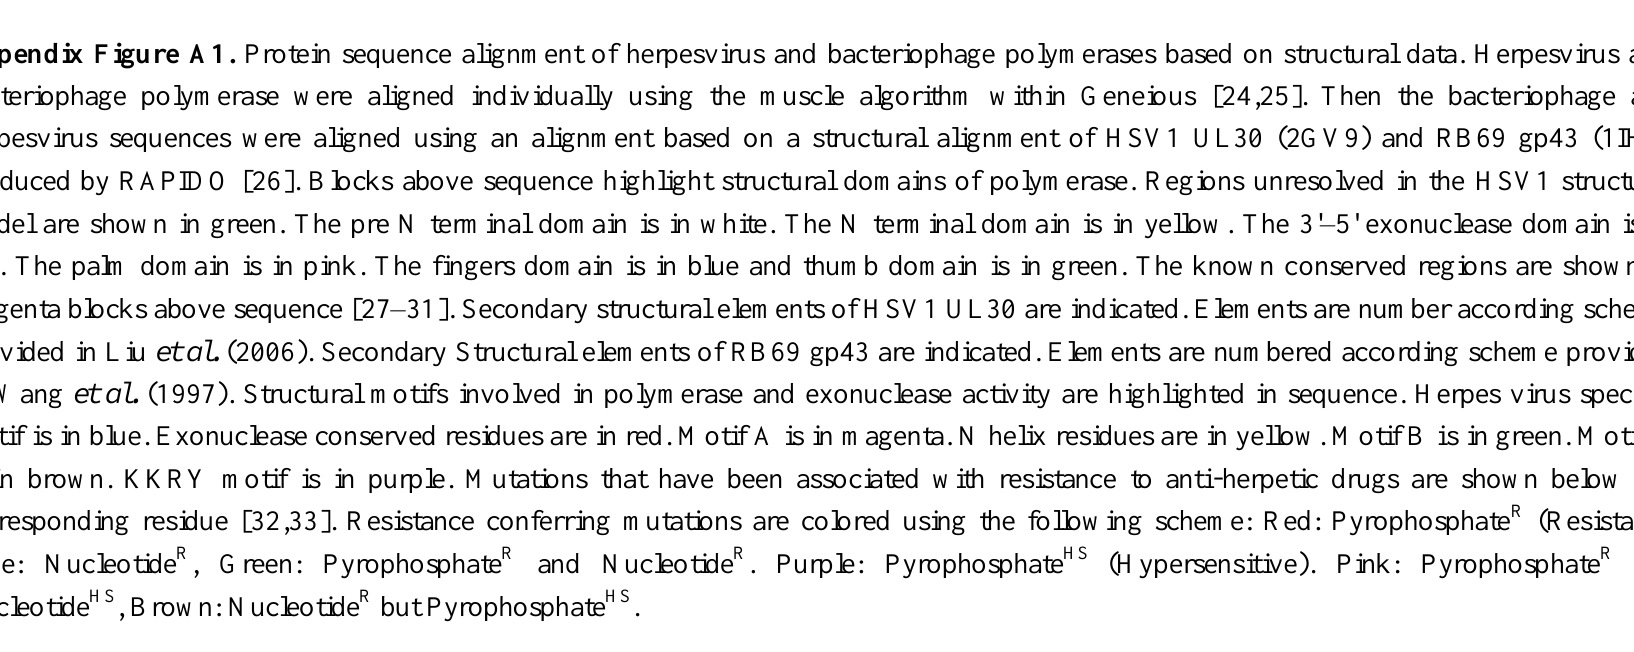
Appendix Figure A1. Protein sequence alignment of herpesvirus and bacteriophage polymerases based on structural data. Herpesvirus and bacteriophage polymerase were aligned individually using the muscle algorithm within Geneious [24,25]. Then the bacteriophage and herpesvirus sequences were aligned using an alignment based on a structural alignment of HSV1 UL30 (2GV9) and RB69 gp43 (1IH7) produced by RAPIDO [26]. Blocks above sequence highlight structural domains of polymerase. Regions unresolved in the HSV1 structural model are shown in green. The pre N terminal domain is in white. The N terminal domain is in yellow. The 3'–5' exonuclease domain is in red. The palm domain is in pink. The fingers domain is in blue and thumb domain is in green. The known conserved regions are shown in magenta blocks above sequence [27–31]. Secondary structural elements of HSV1 UL30 are indicated. Elements are number according scheme provided in Liu et al. (2006). Secondary Structural elements of RB69 gp43 are indicated. Elements are numbered according scheme provided in Wang et al. (1997). Structural motifs involved in polymerase and exonuclease activity are highlighted in sequence. Herpes virus specific motif is in blue. Exonuclease conserved residues are in red. Motif A is in magenta. N helix residues are in yellow. Motif B is in green. Motif C is in brown. KKRY motif is in purple. Mutations that have been associated with resistance to anti-herpetic drugs are shown below the corresponding residue [32,33]. Resistance conferring mutations are colored using the following scheme: Red: Pyrophosphate R (Resistant), Blue: Nucleotide R , Green: Pyrophosphate R and Nucleotide R . Purple: Pyrophosphate HS (Hypersensitive). Pink: Pyrophosphate R but Nucleotide HS , Brown: Nucleotide R but Pyrophosphate HS